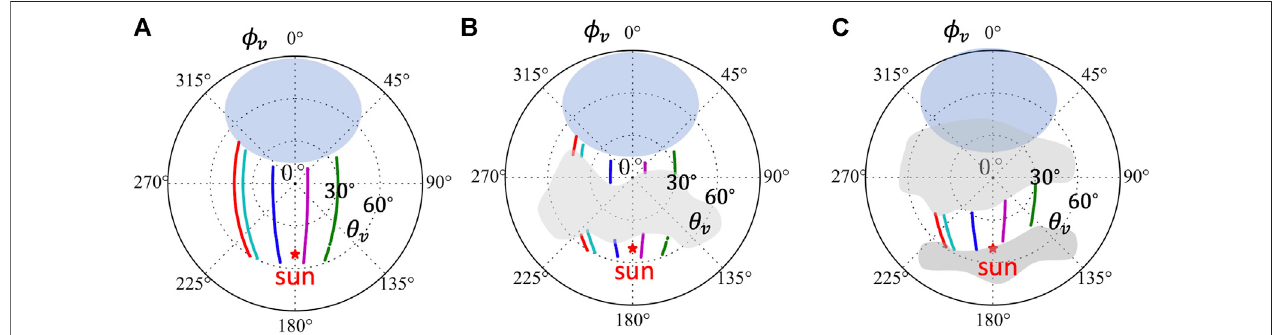
FIGURE 3 | The sampled viewing directions ( θ v , ϕ v ) in the polar plot (four examples are shown with different color lines): (A) with all angles after excluding sunglint (theblueoval); (B) cloudblockingthecentralregion; (C) cloudblockingbothsides.Whenthecloudsizesaresmallerenough,bothb)andc)approachto (A) .Theasterisk indicate the antisolar point.